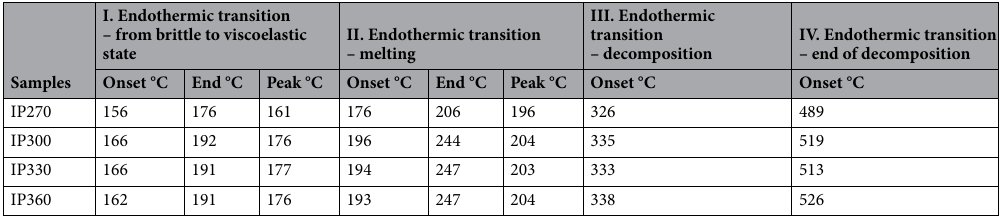
Table 2. Phase change temperature from DSC analysis.